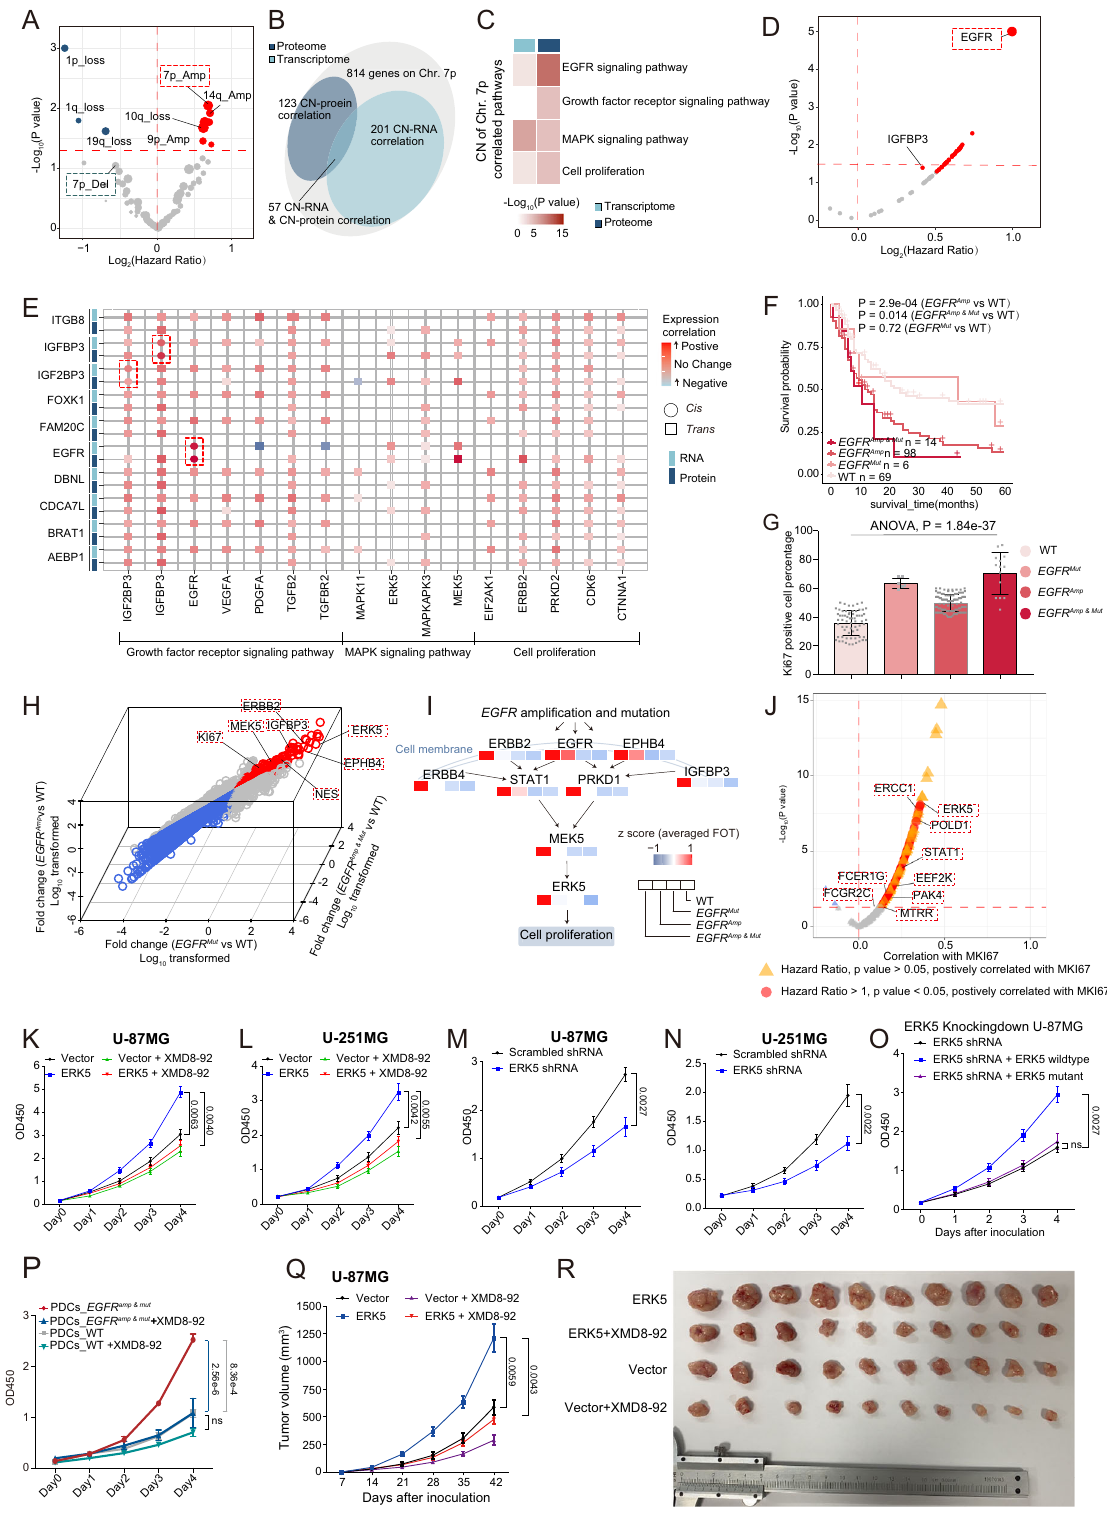
ERK5 activates PRPS1 and PRPS2 and promotes nucleotide